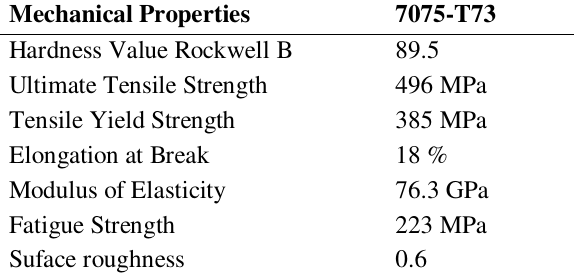
Mechanical properties of AA 7075-T73 as taken from the SIER and/or